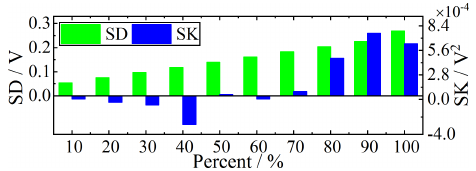
Figure 8. The standard deviations (SDs) and skewness values (SKs) of synthetic impulsive